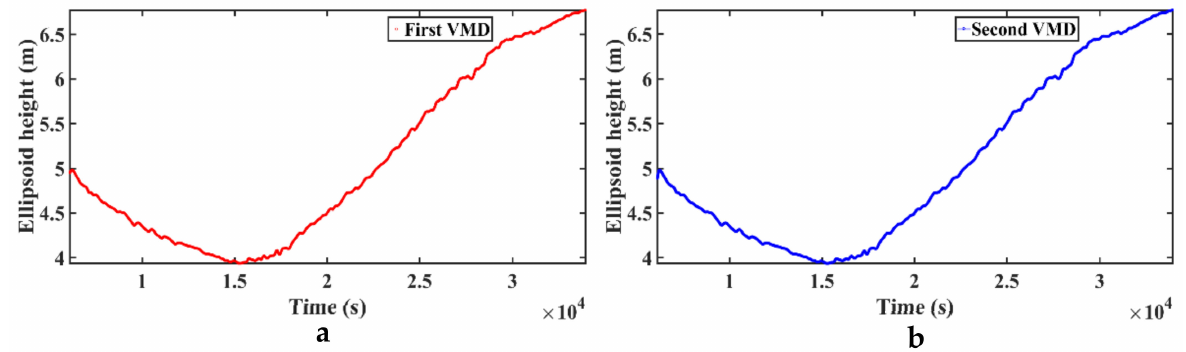
Figure 13. ( a ) The signal after the first modal decomposition. ( b ) The signal after the second modal decomposition.